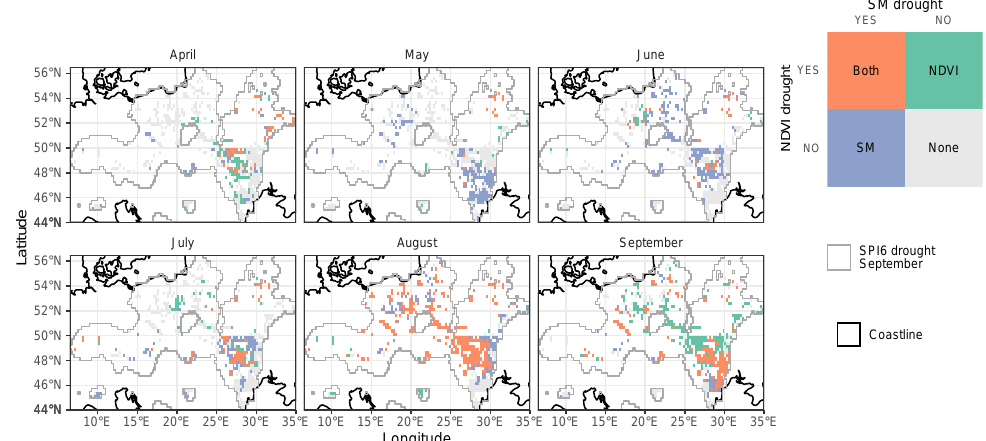
Figure 3. Synchrony between the soil moisture and vegetation droughts during the 2015 growing season in the agricultural grid cells. Note the asynchronous development of soil moisture and vegetation drought, with soil moisture drought dominating in May–June, and vegetation in April and September. Similar figures for the other drought events are included in the Supplementary Materials (Figures S1–S5).